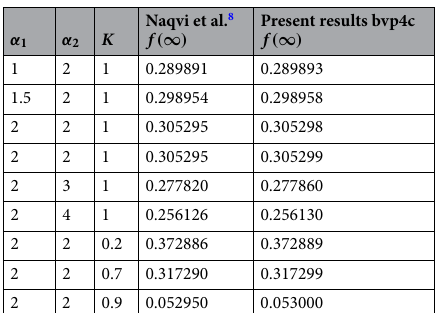
7, Sc 0.5, N 0.1, N 0.6 t = b = = =